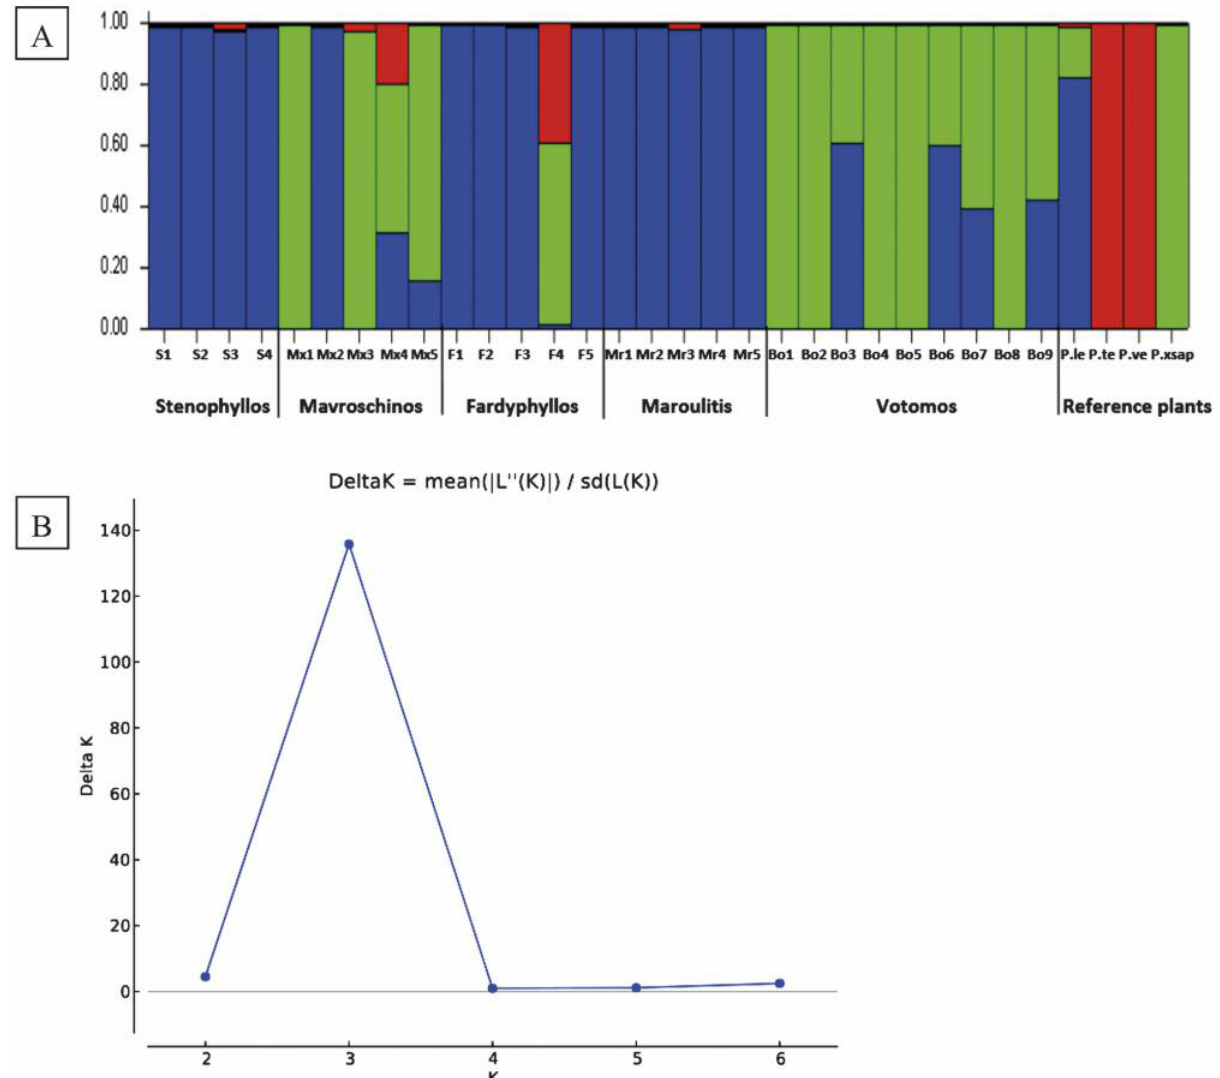
Figure 7 A STRUCTURE analysis of the data from the five morphotypes of mastic trees based on ITS1 and ITS2 data, with K = 3 clusters (Δ K higher value, Fig. 7 B). Each vertical bar represents a single plant (n = 32) and the probability of its membership in 3 clusters. B Estimation of the number of populations for K , from 1 to 7, by calculating delta K values [37].The five morphotypes “Stenophyllos”, “Mavroschinos”, “Fardyphyllos”, “Maroulitis” and “Votomos”, compared genetically with the four reference plants P. lentiscus (P.le), P. terebinthus (P.te), P. vera (P.ve) and P . x saportae